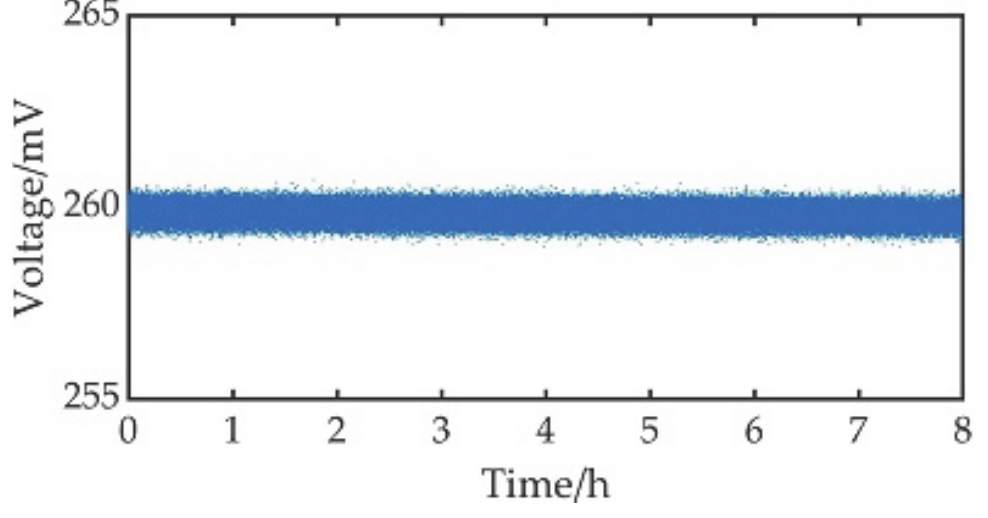
Figure 5. Simulation results of PD output voltage in Experiment 1.